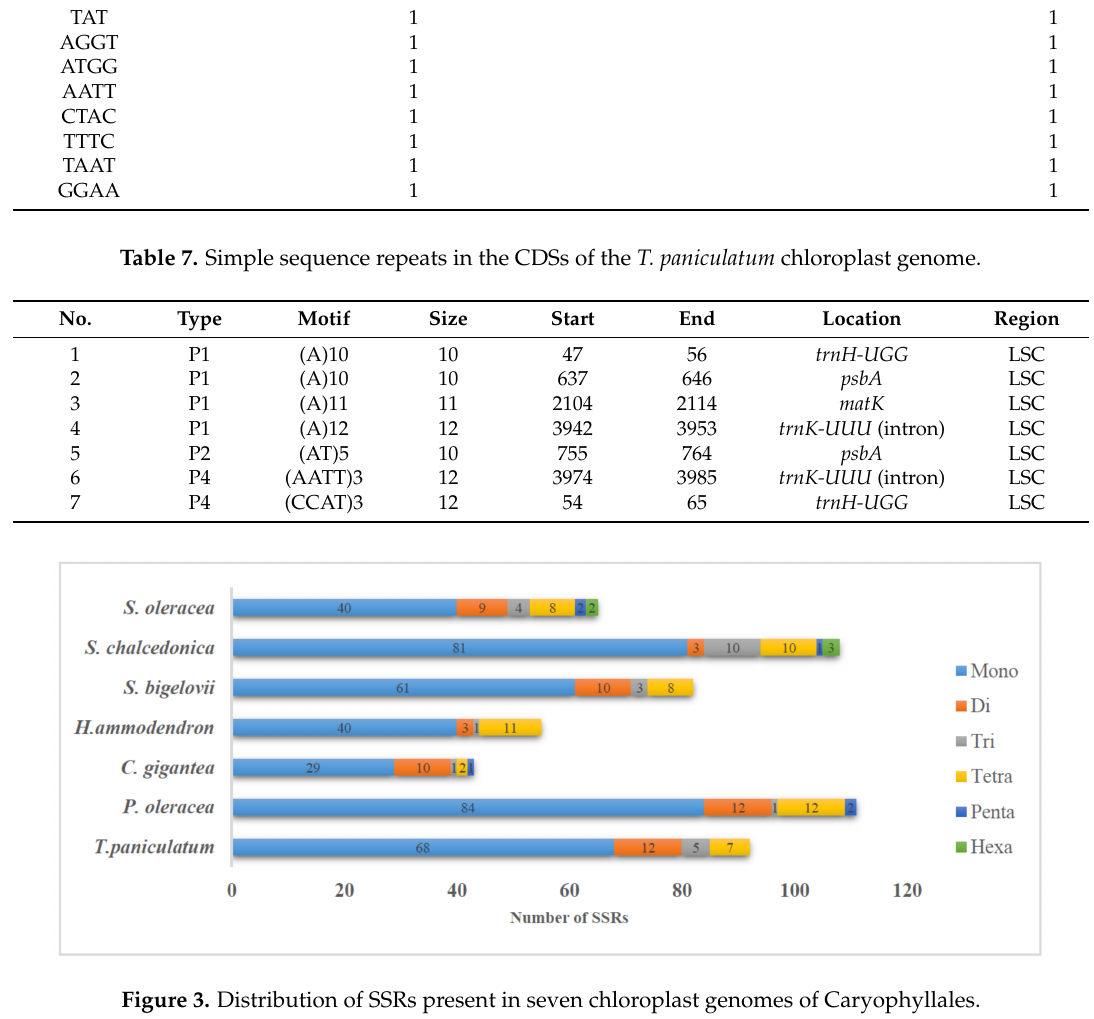
Figure 3. Distribution of SSRs present in seven chloroplast genomes of